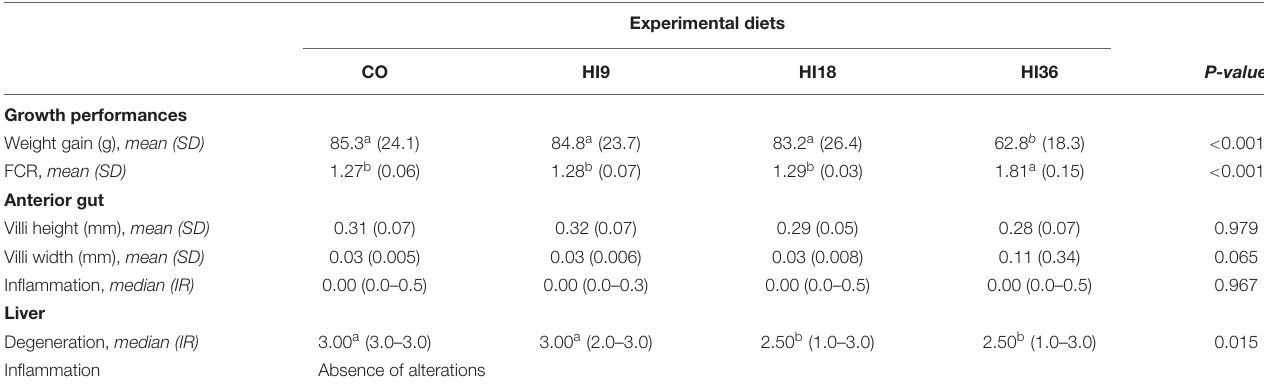
TABLE 3 | Growth performances and histopathological traits divided by diet